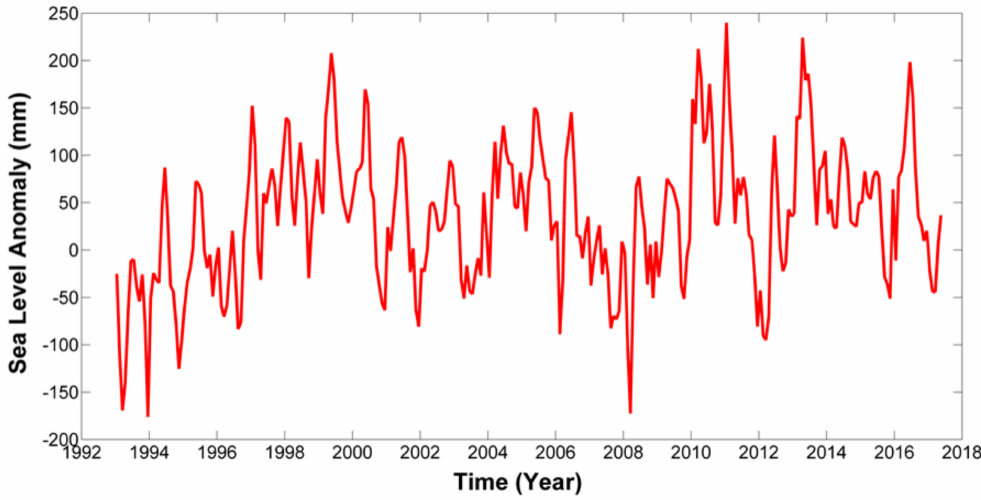
Figure 2. Monthly sea level time series from January 1993 to May